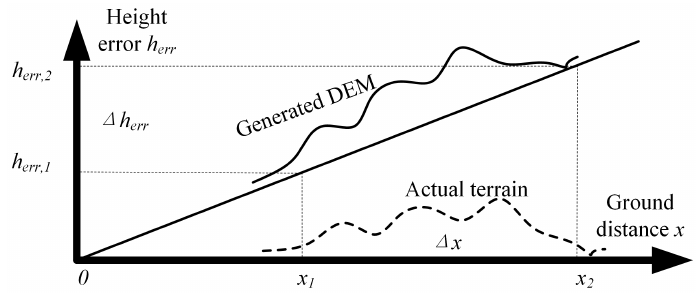
Figure 3. Estimation of range tilt. The dotted line represents the actual terrain, the solid line represents the generated DEM, and the longitudinal axis represents the height difference between the generated DEM and the actual terrain; x 1 and x 2 are the ground distance coordinates of two different GCPs, h err ,1 and h err ,2 are their systematic elevation errors, and ∆ h err = h err ,2 − h err ,1 and ∆ x = x 2 − x 1